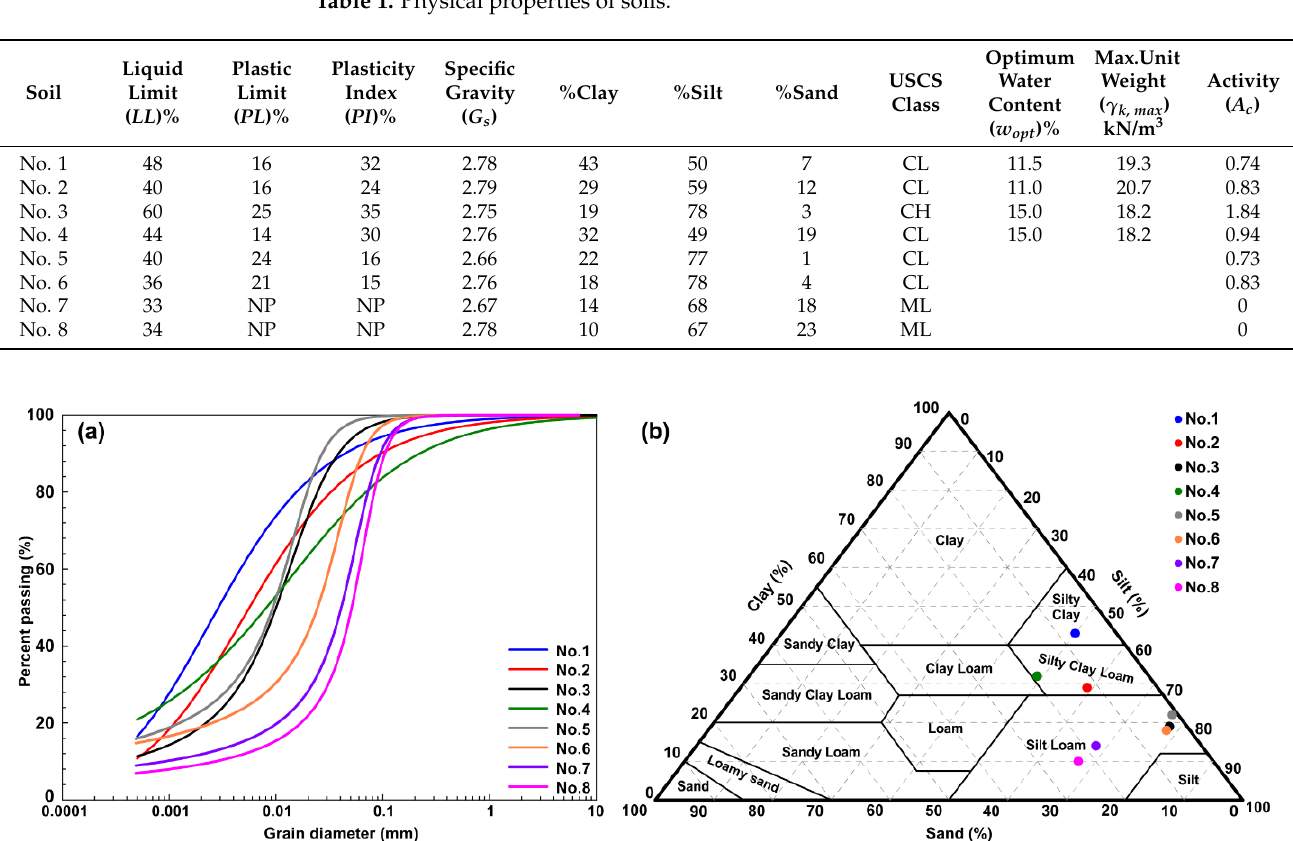
Table 1. Physical properties of soils.